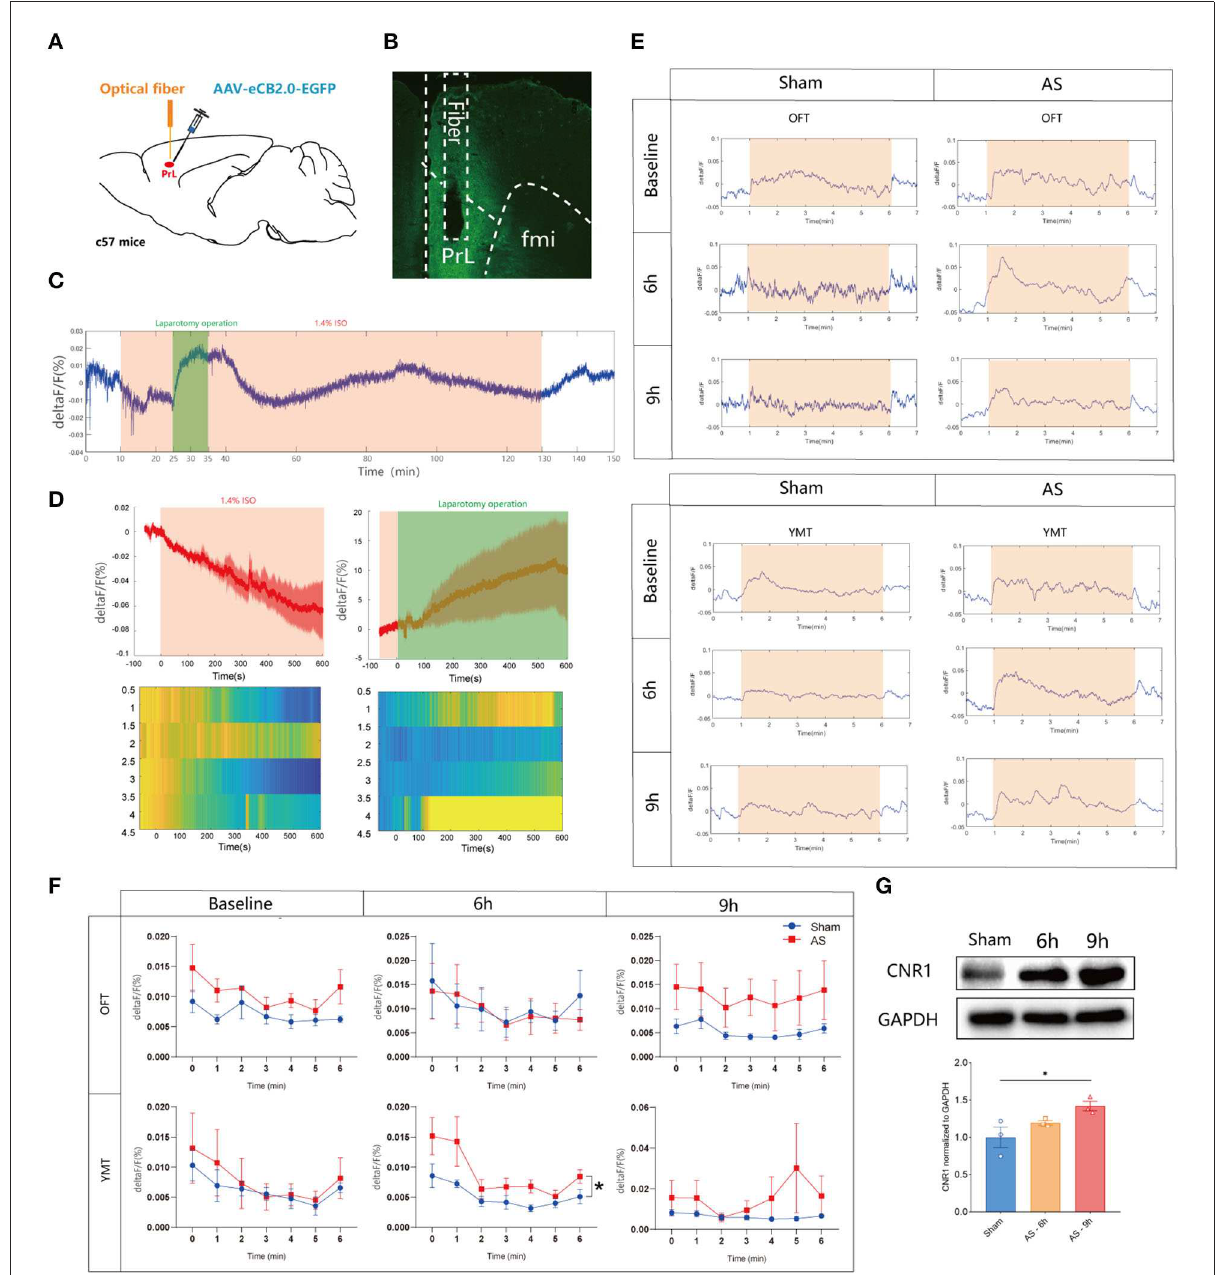
FIGURE2 The eCB signals in the PrL during AS and behavioral tests. (A) Scheme of the viral microinjection and fiber implantation. (B) The fiber location and viral expression. (C,D) The typical traces (C) and analyzed figure (D) of the eCB signal during AS. (E,F) The typical curves (E) and statistical chart (F) of the eCB signal during the open field and Y maze tests. (G) The expression of CB1R in the PrL after AS. Data are shown as mean ± SEM. N = 4. * P < 0.05. AS, anesthesia and surgery; OFT, open field test; YMT, Y maze test.